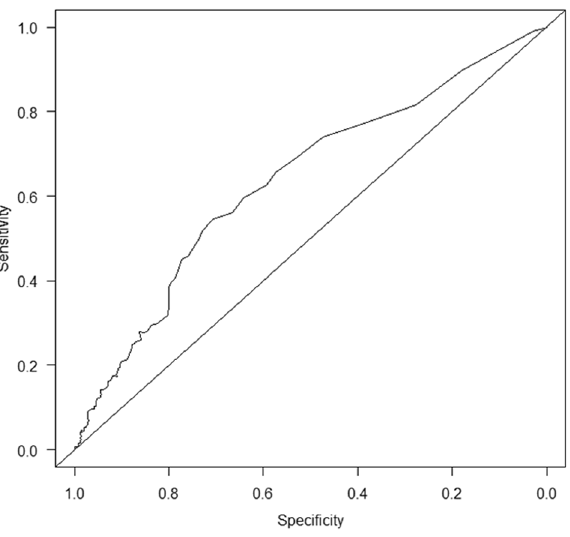
Figure 2. Time-dependent ROC curve of CAR for overall survival at 20 months after the start of follow-up. The area under the ROC curve was 0.638. Sensitivity and specificity using the CAR cutoff value of 0.108 according to the Youden index were 54.7% and 71.0%, respectively. ROC, receiver operating characteristic; CAR, C-reactive protein to albumin ratio.